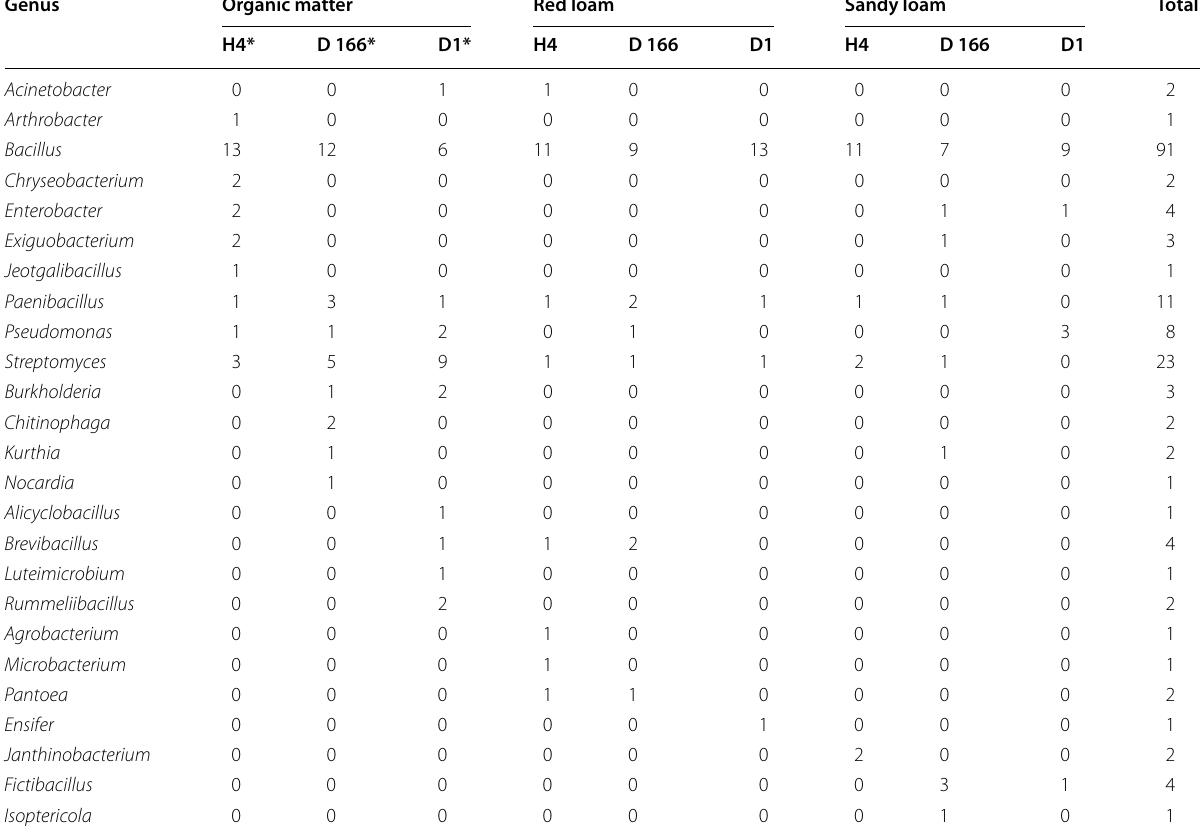
*Huidan 4: H4, Diangu 166: D166, Diangu 1: